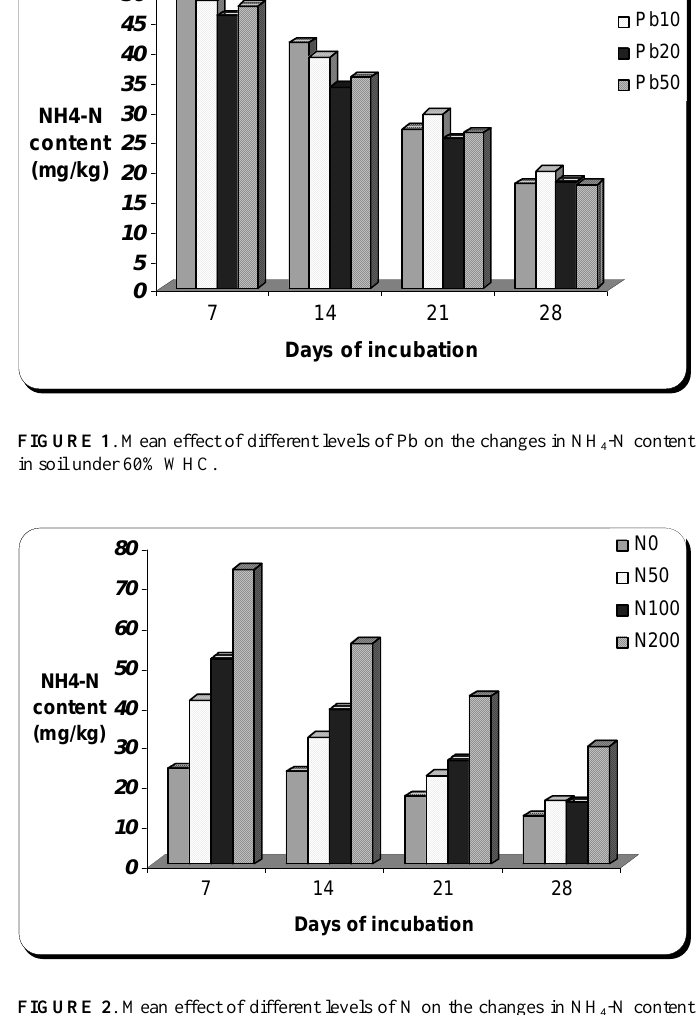
FIGURE 2 . Mean effect of different levels of N on the changes in NH 4 -N content in soil under 60%